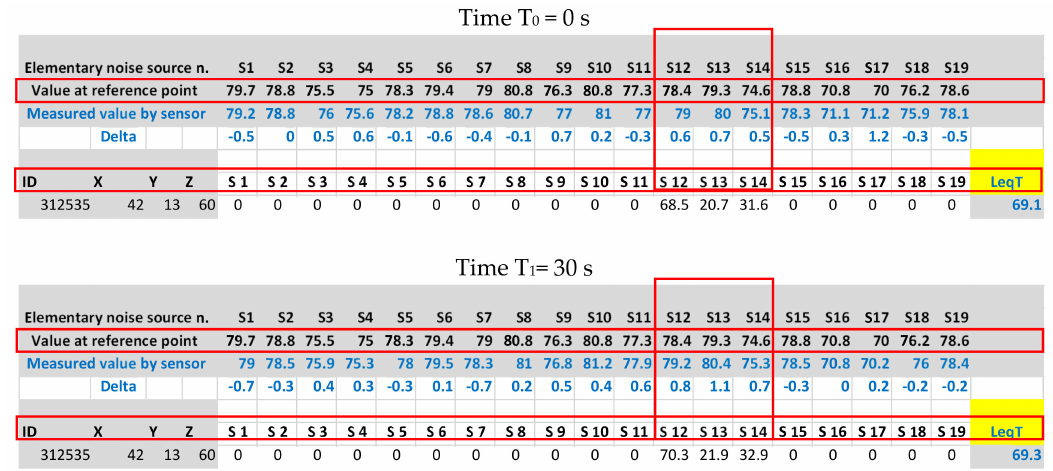
Figure 7. Example of a map update related to point grid ID = 312535 at time T 0 = 0 s and after 30 s (T 1 = 30